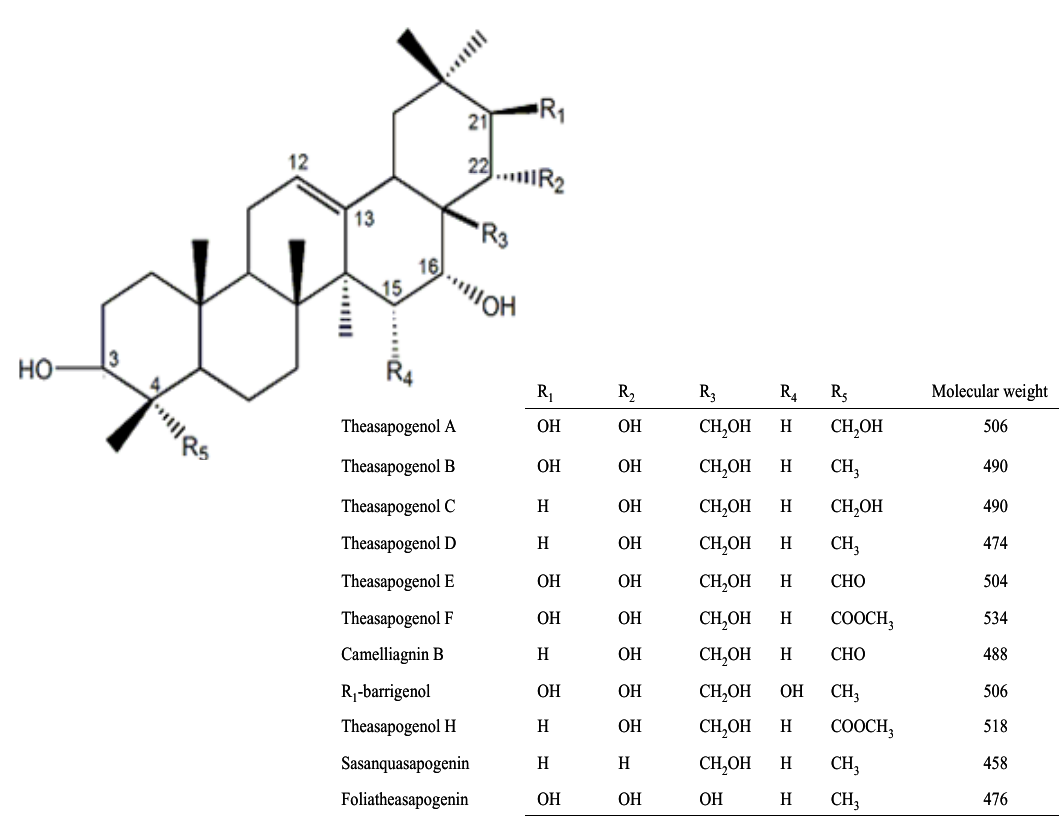
Figure 3. The genin structures of triterpene